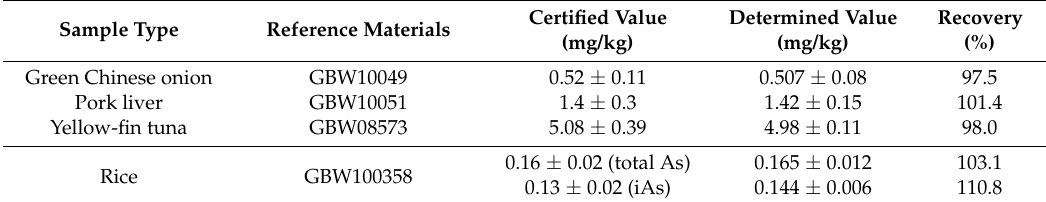
Table 3. National standard reference materials values (mg/kg, mean ± standard deviation) and determined values for total As and inorganic arsenic (iAs) content ( n =